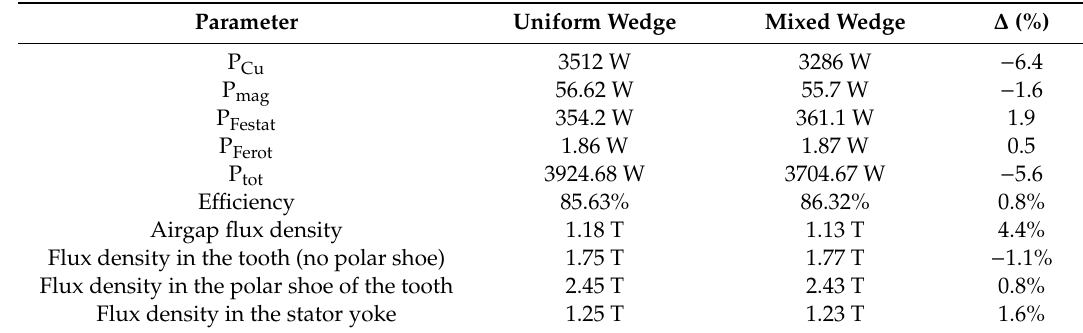
Table 5. Power losses, e ffi ciency, and flux densities of the motor at full load. Parameter Uniform Wedge Mixed Wedge